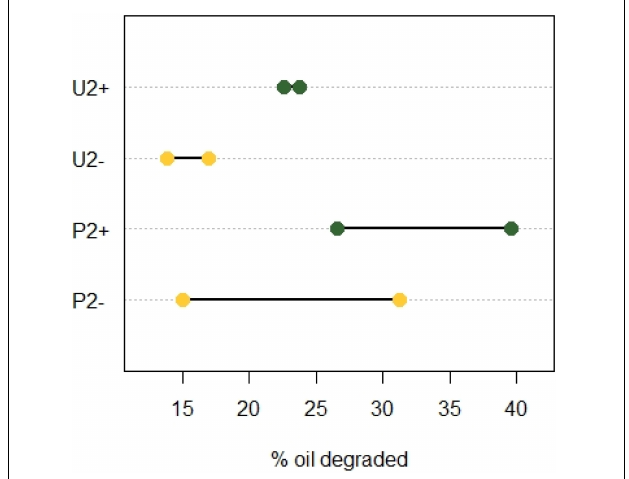
FIGURE 2 | Crude oil degraded in incubation 2 after 2 months with or without polypropylene particles using two enriched soil communities. One from an untreated soil (U) and the other from a soil pre-exposed to crude oil (P). Yellow, cultures without oil absorbent material ( − ); green, cultures with oil absorbent material ( + ). The X-axis shows the percentage of oil degraded with respect to the weathering control ( N =